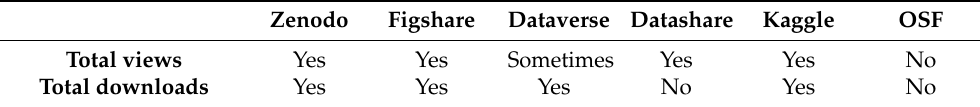
Table 3. Overview of the type of usage statistics provided by each of the repositories represented in our dataset.